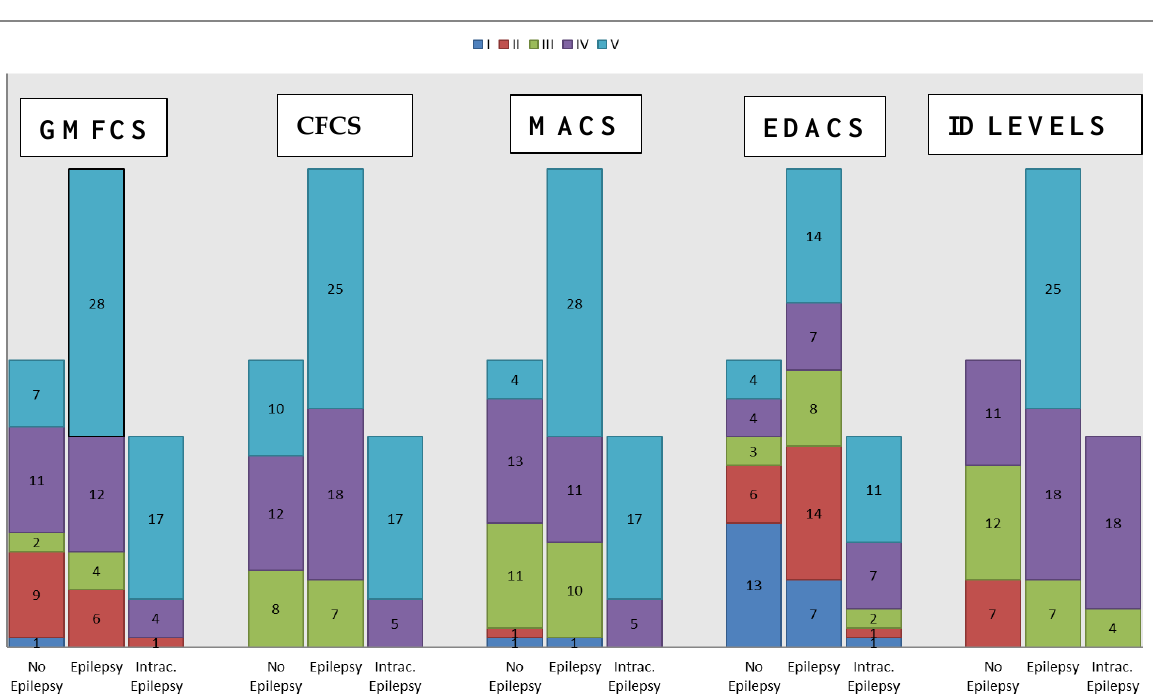
Figure 1. Distribution of patients according to the Manual Ability Classification System [MACS], Gross Motor Function Classification System (GMFCS), Eating and Drinking Ability Classification System (EDACS), Communication Function Classification System (CFCS), and Intellectual Disability (ID) levels [6].